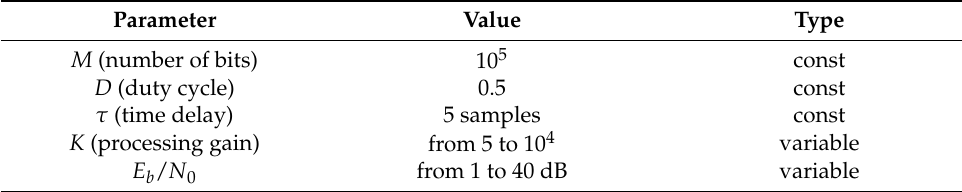
Table 1. Simulation parameters.